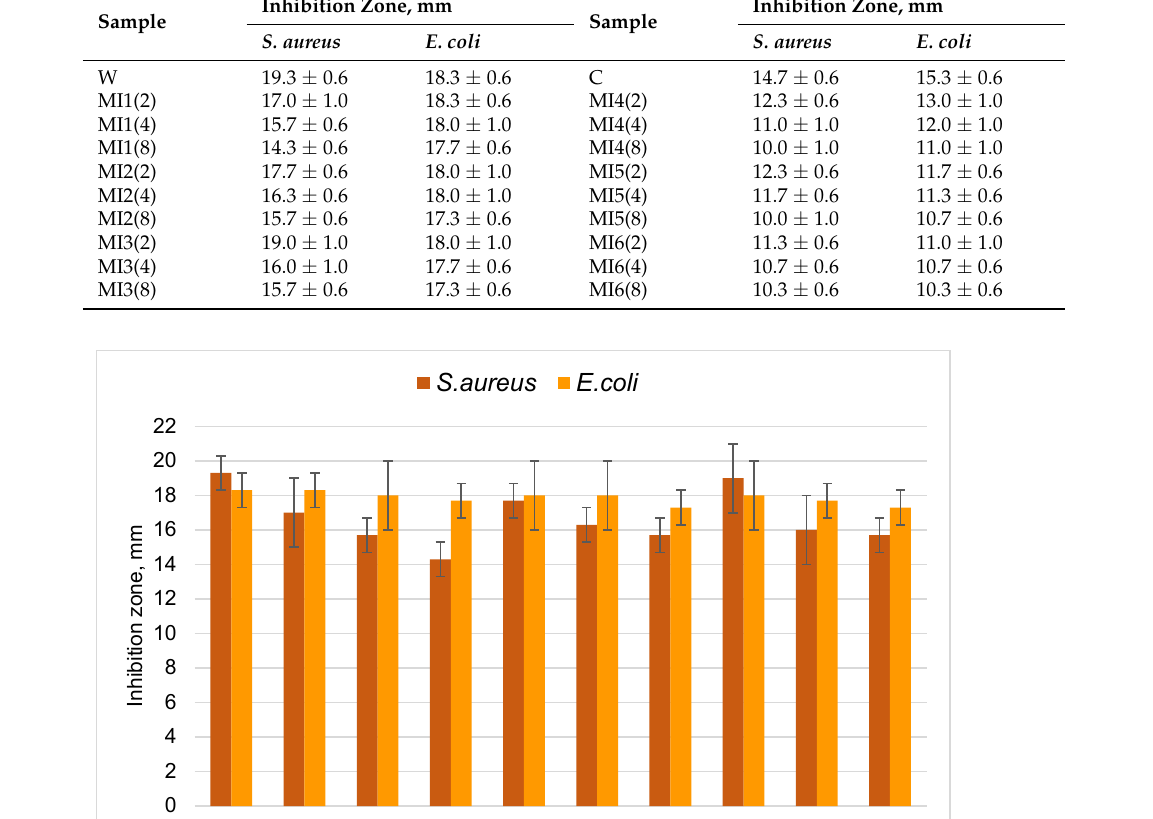
Figure 6. Diameters (mm) of inhibition zones against S. aureus and E. coli bacteria of modified wool knitted fabric inserts used in reusable masks. W is the non-worn sample; MI1 (2), MI2 (2) and MI3 (2) after 2 h of wearing; MI1 (4), MI2 (4) and MI3 (4) after 4 h of wearing; MI1 (8), MI2 (8), and MI3 (8) after 8 h of wearing.